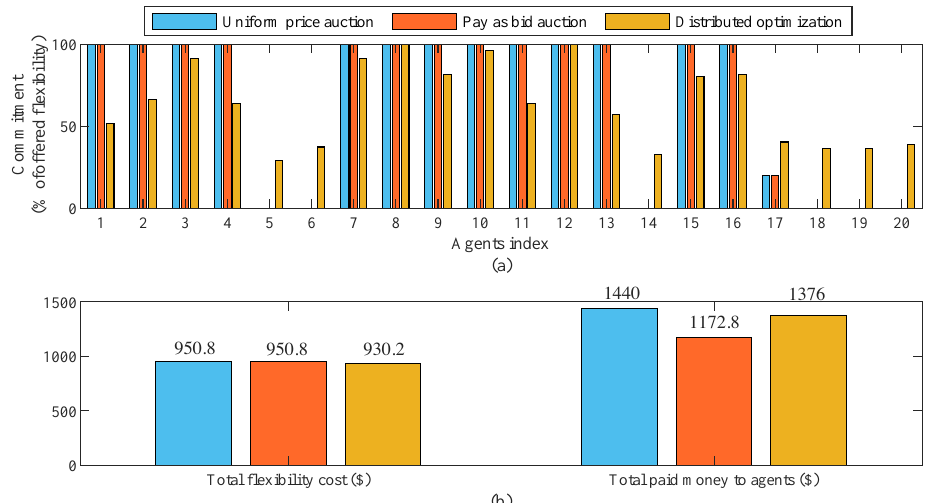
Figure 11. Results comparison: ( a ) Agents’ commitment ( b ) Total flexibility cost and paid money to